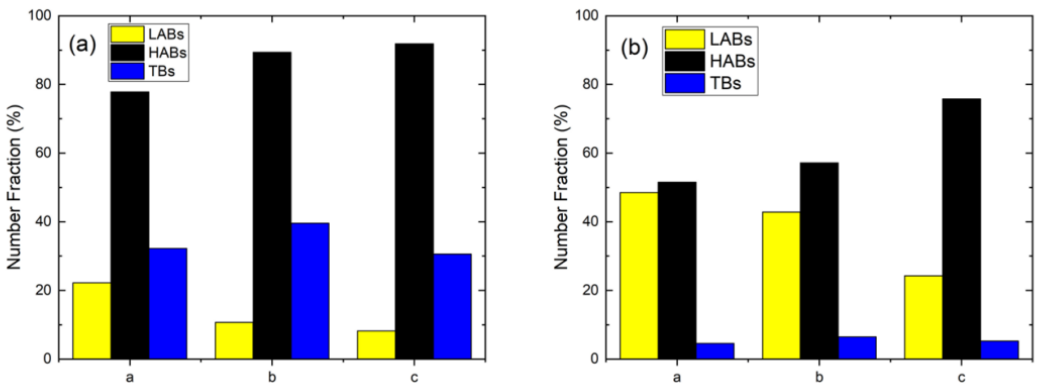
Figure 13. The fraction of LABs, HABs, and TBs in different regions along the centerline for FSPed SAF 2507: ( a ) γ/γ boundaries and ( b ) α/α boundaries.